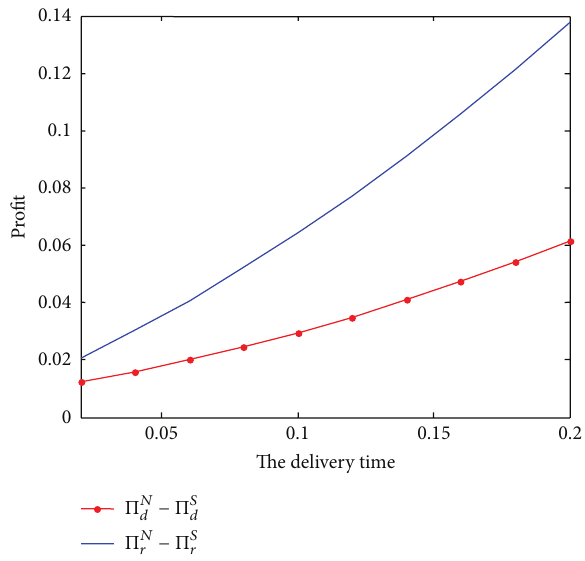
Figure 6: Profit gap between Nash equilibrium and Stackelberg game with the delivery time.